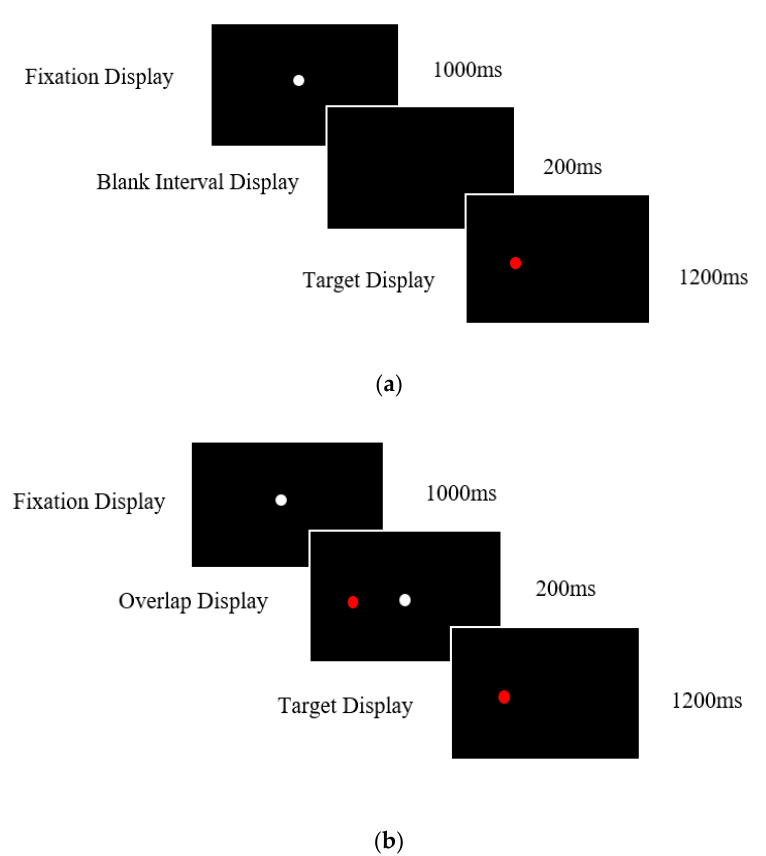
Figure 1. Gap and Overlap Displays ( a ) Timings and sequence of the prosaccade task gap condition.